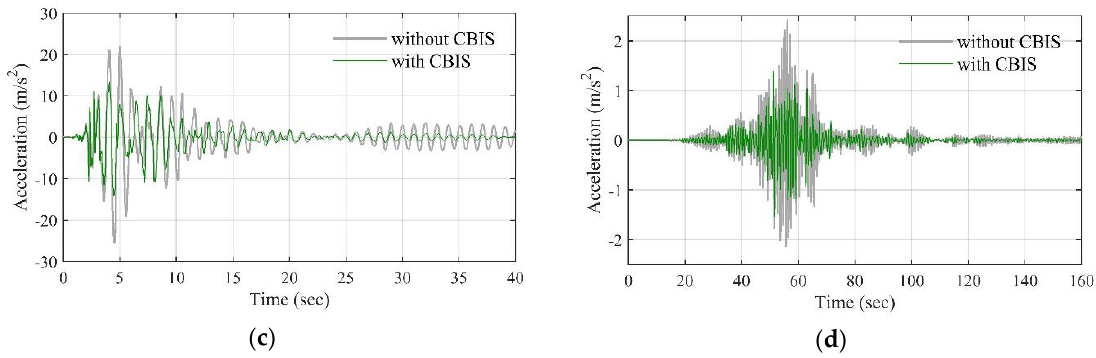
Figure 10. Acceleration response time histories for two test frame roofs during ( a ) the El Centro wave, ( b ) the Tohoku wave recorded by Tohoku University, ( c ) the Kobe record and ( d ) the Chi – chi record.